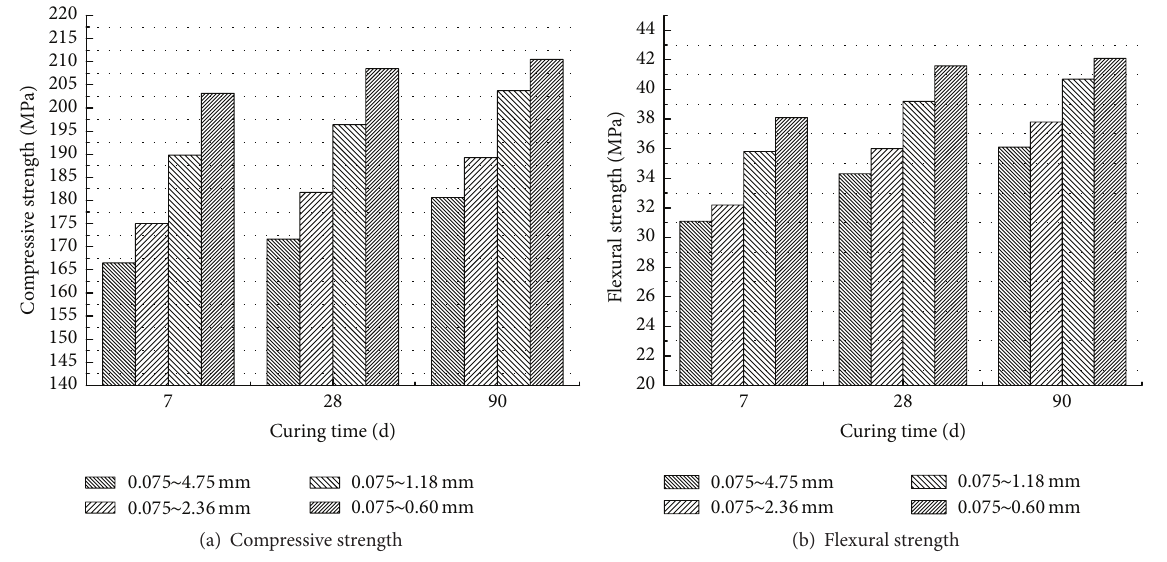
Figure 4: The influence of aggregate size on strength.